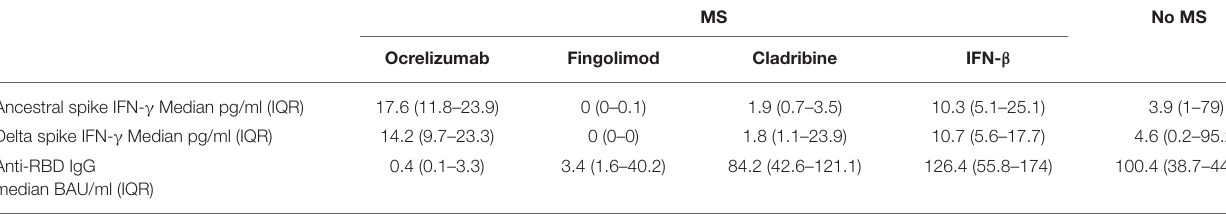
TABLE 2 | Medians and IQR of IFN- γ and anti-RBD IgG levels in MS patients and “no MS” subjects.